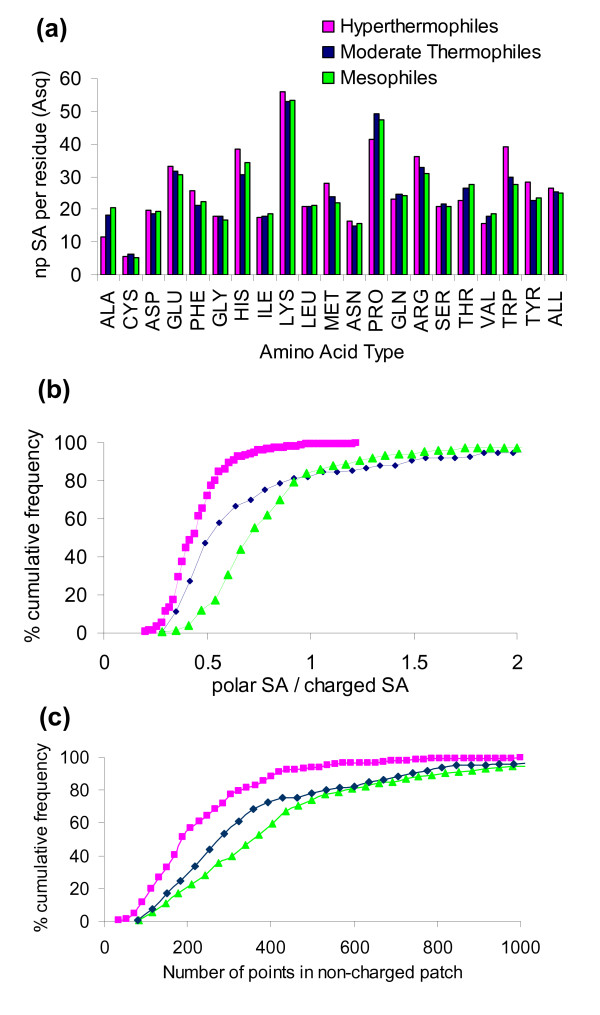
Accessible surface area properties. (a) Non-polar solvent accessible surface area per residue for each residue type. (b) Separation by cumulative distributions of the ratio of polar to charged solvent accessible surface area for each protein in the 291 set. (c) Separation by the size (number of points) of the largest patch that does not contain a group bearing net charge.